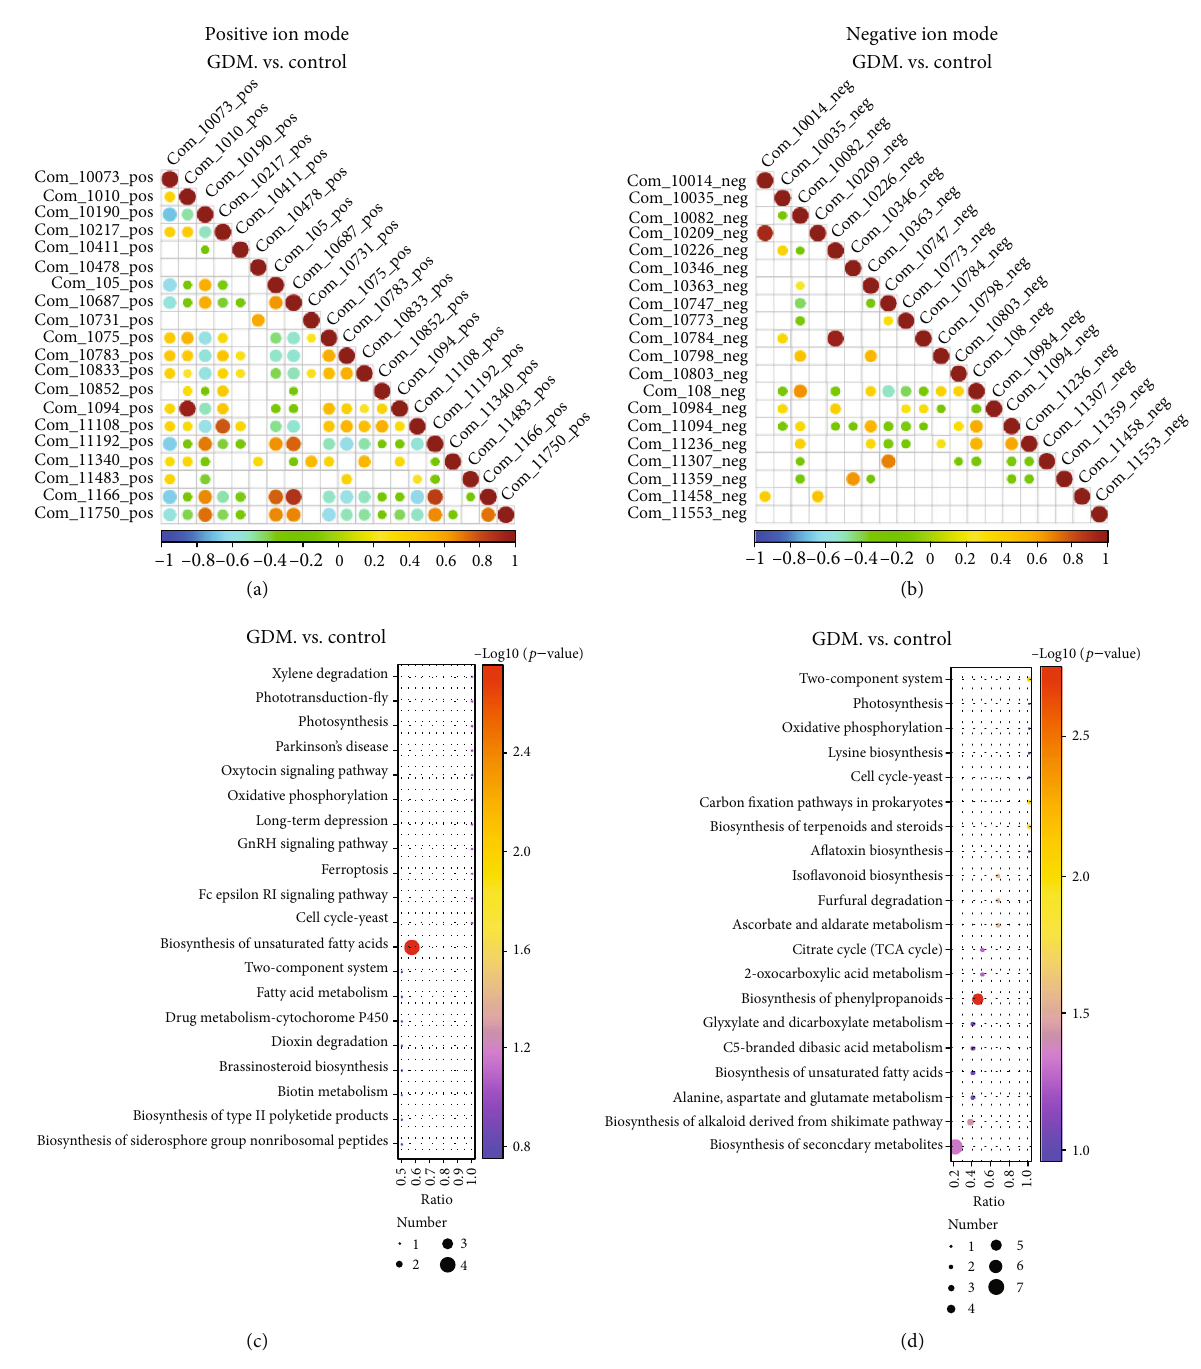
Figure 3: Di ff erential metabolite KEGG pathway enrichment map. (a, b) When the linear relationship of the two metabolites is enhanced, the correlation coe ffi cient tends to 1 or -1; when positive correlation, it tends to 1, and when it is negatively correlated, it tends to -1. The correlation is a maximum of 1, a complete positive correlation (red), a correlation of -1, and a complete negative correlation (blue). (c, d) KEGG analysis was used to identify the pathways which were signi fi cantly enriched by di ff erential metabolites compared to all identi fi ed metabolite backgrounds. (a, c) Positive ion mode. (b, d) Negative ion